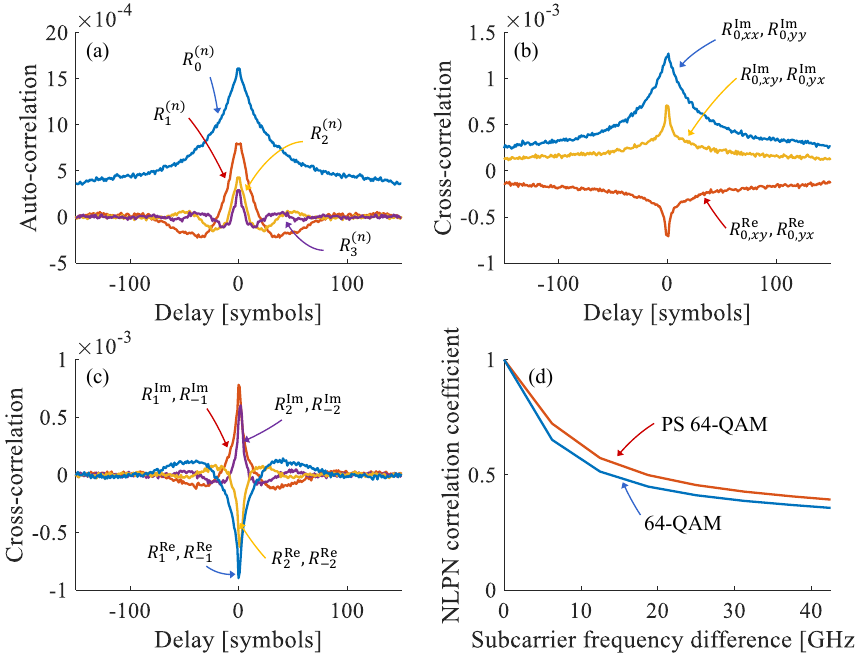
Figure 2. Examples of different auto-correlation and cross-correlations characterizing NLIN. ( a ) the auto-correlation functions of the first 4 ISI components. ( b ) cross-correlation functions between different ( n ) elements of the ISI matrix R , and ( c ) cross-correlation between different ISI orders. The superscripts 0 Re and Im denotes the real and imaginary parts of the coefficients, whereas the subscripts xx , xy , yx , and yy denote the four components of a 2 × 2 ISI matrix. For example, the curve marked by R Re , R Re denotes the cross-correlation between the real part of the off-diagonal elements of R 0, xy 0, yx ( d ) normalized (Pearson) correlation of the phase-noise component in a multi-subcarrier system. The curves show the correlation between the phase noise affecting two tributaries within the COI, as a function of the frequency separation between them. Results are shown for 64-QAM modulation, and probabilistically-shaped (PS) 64-QAM. All of the results were obtained for a 10 × 100 km link of SMF. The auto-correlation and cross-correlation functions of figs. ( a – c ) were measured for a system carrying 15 WDM channels, whereas in fig ( d ) 21 WDM channels where